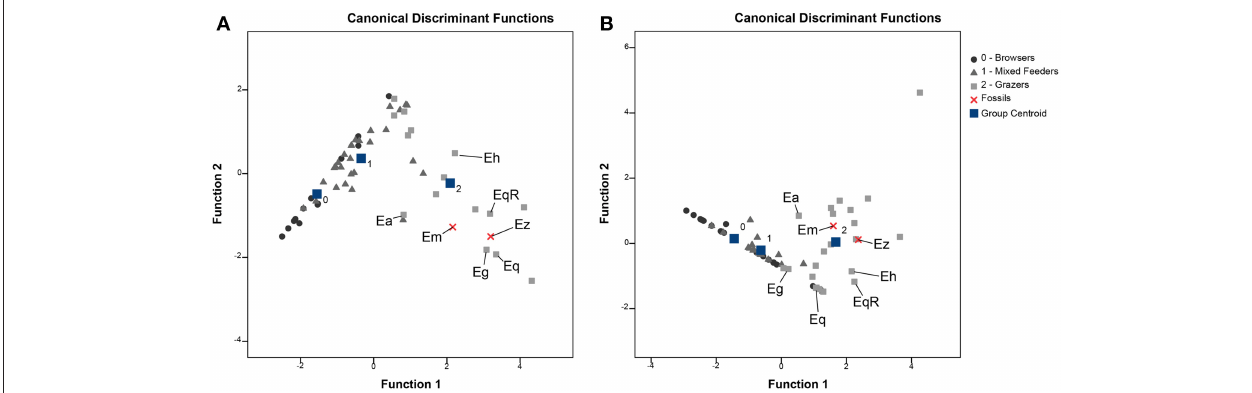
FIGURE 3 | Bivariate diagrams based on discriminant analysis: conservative classification (A) and radical classification (B) . Minute abraded brachydont species have been excluded. Fossil taxa Ez, Equus senezensis aff. E. sen. stehlini ; Em, Equus cf. E. mosbachensis ; Eq, Equus quagga ; EqR, Equus quagga (Rumuruti population); Eg, Equus grevyi ; Eh, Equus hemionus ; Ea, Equus asinus . Group centroids: browsers (0); mixed feeders (1); grazers (2).